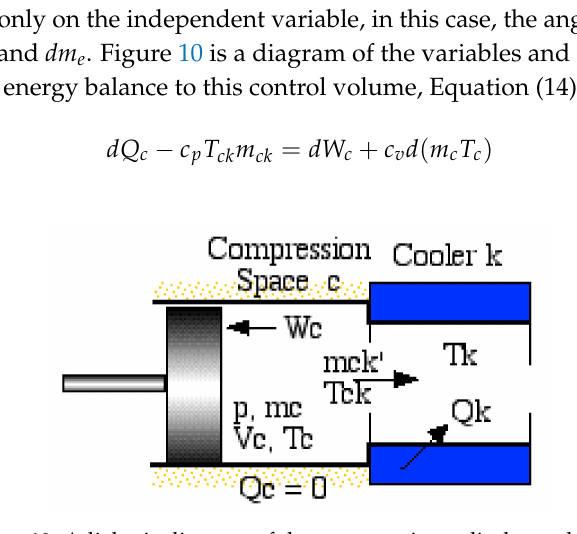
Figure 10. Adiabatic diagram of the compression cylinder and